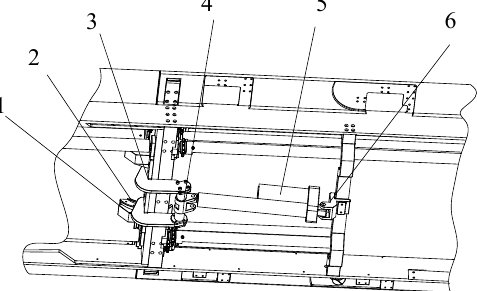
Figure 11. The structural design of the back-lifting part; 1—back-lifting chute; 2—the back-lifting wheel frame; 3—the ear bracket of the push rod; 4—the head bracket of the push rod; 5—the push rod; 6—the end bracket of the push rod.